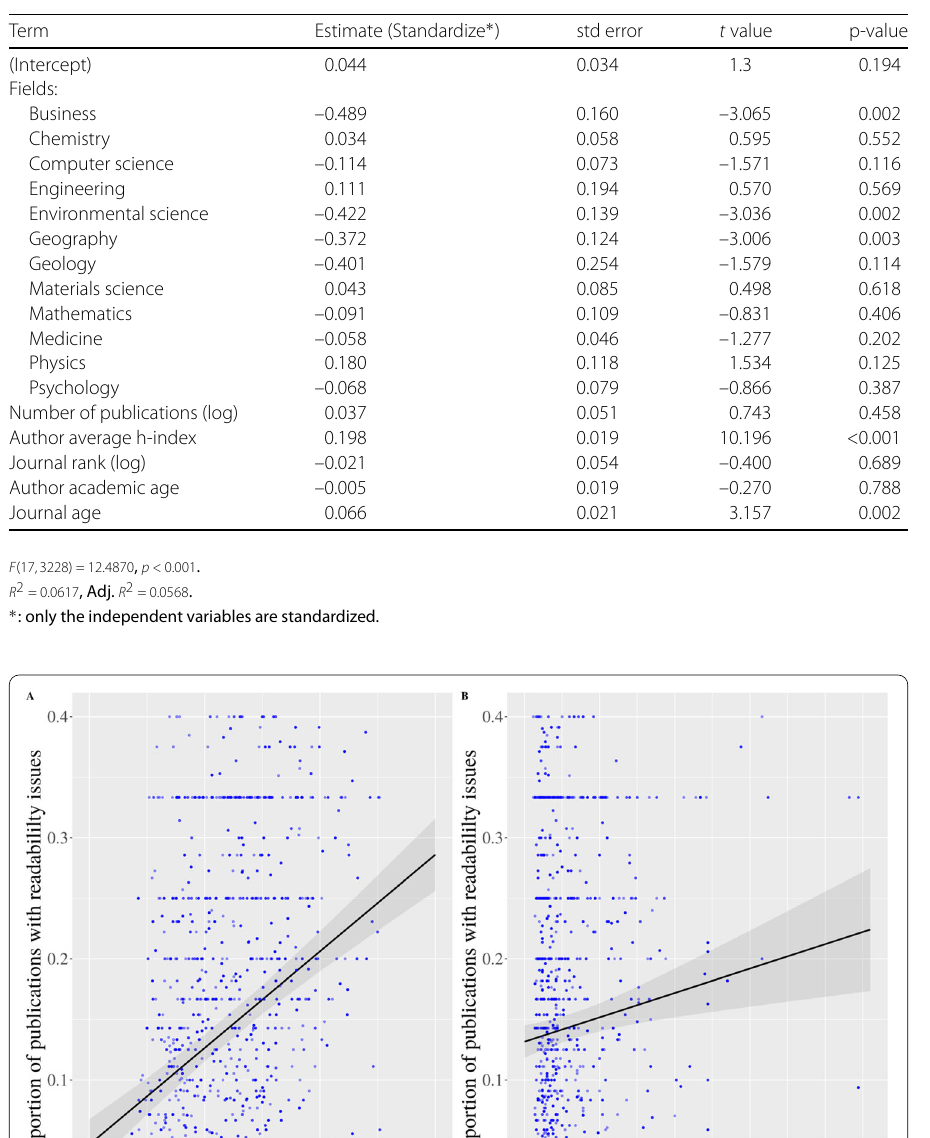
Table 3 Linear regression (standardized coefficients) on journals’ proportion of publications with readability issues